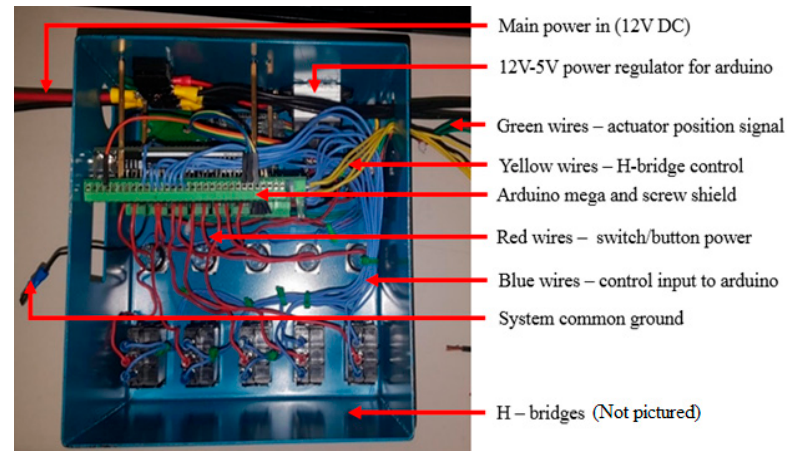
Figure 2. Wiring of developed control box for precise actuator positioning on a DBE wild blueberry harvester.